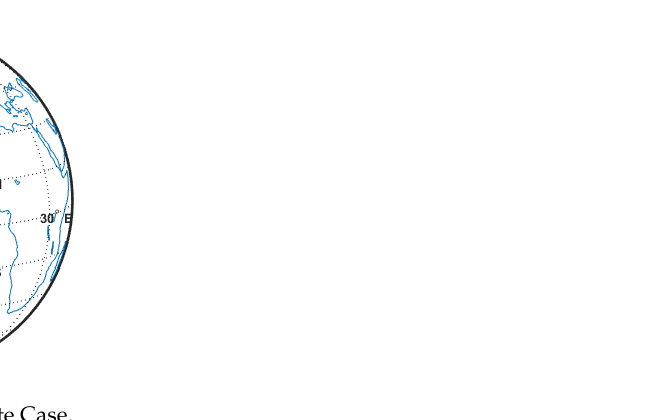
Figure 17. The Atlantic Route Case.